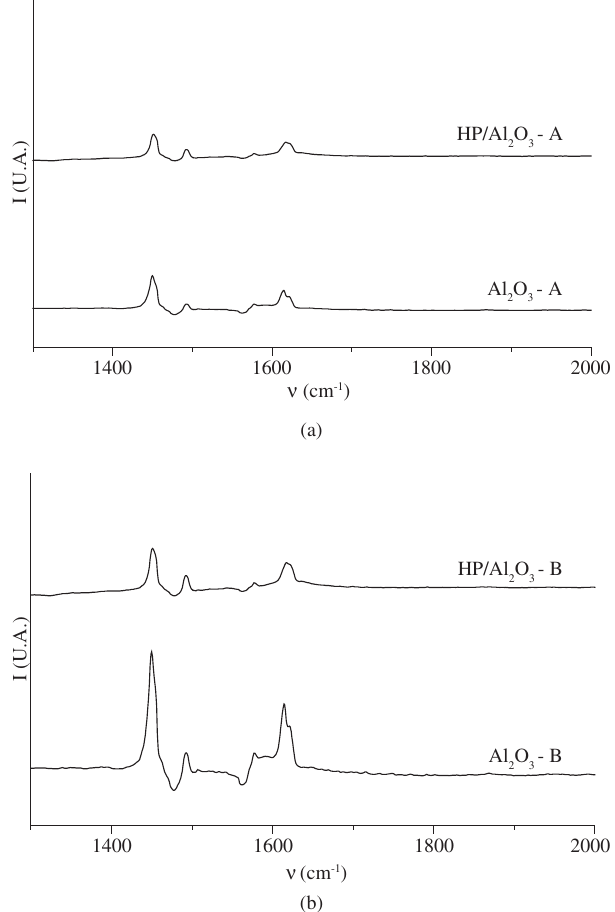
O - A; and b) Al 2 3